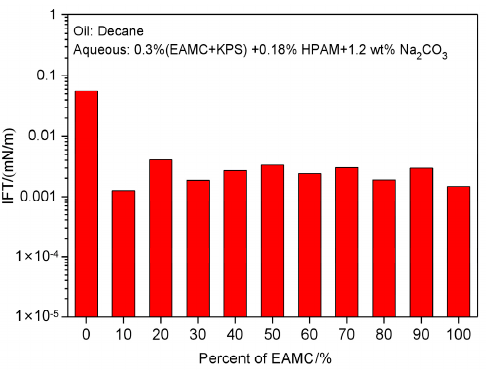
Figure 5. The effect of the percentage of EAMC on the IFTs of KPS and HPAM solutions. The Alkali Tolerance of KPS and EAMC, and HPAM Solutions Based on the experimental results and surfactant economic costs, the following for- mula was selected: 0.3 wt % surfactants (KPS: EAMC, 8:2), 0.18 wt % HPAM andNa 2 CO 3 . Figure 6 shows the effects of the alkali concentration on the dynamic IFTs. The IFT of formula system decreases by 10 − 3 mN/m order of magnitude when the alkali concentration increases. The preferable alkali concentration range of Na 2 CO 3 is from 0.6 wt % to 1.4 wt % and the optimal Na 2 CO 3 concentration is 1.2 wt %. Figure 6. The effect of Na 2 CO 3 on the dynamic IFTs of KPS and EAMC, and HPAM solutions. The Effect of Ca 2+ on the Dynamic IFTs of Chemical Flooding Solutions The effect of Ca 2+ concentration on the IFTs of 0.3 wt % (KPS: EAMC, 8:2)+ 0.18 wt % HPAM+ 1.2 wt % Na 2 CO 3 solution has been studied and the experimental results are plot- ted in Figure 7. As the Ca 2+ concentration increases from 100 mg/L to 300 mg/L, the IFT decreases to 10 − 3 mN/m. Then the IFT increases to 10 − 2 mN/m when the Ca 2+ concentration further increases from 400 mg/L to 800 mg/L. The reasons for this result are that if extra